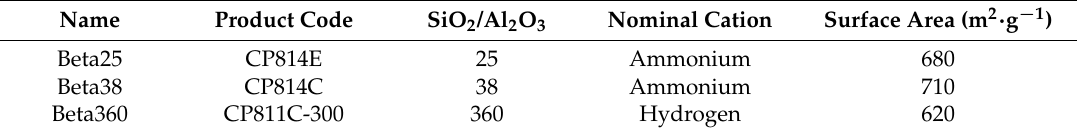
Table 1. Zeolites